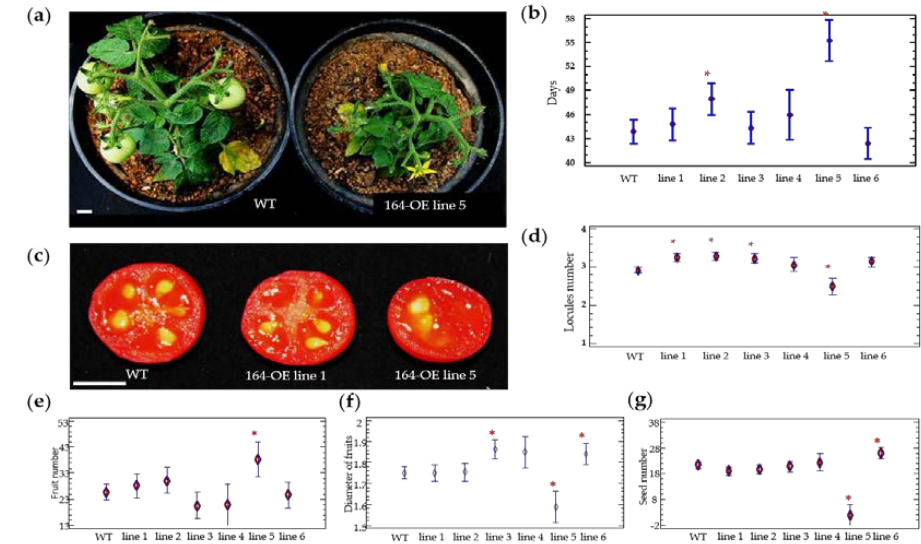
Figure 5. Effect of miR164 overexpression on fruits of tomato. ( a ) Comparison of wild type (WT) and 164-OE line 5 plants of 50 days of age; ( b ) Days that the different lines required to develop the first fruit, WT n = 10, line 1 n = 5, line 2 n = 5, line 3 n = 5, line 4 n = 3, line 5 n = 3, line 6 n = 6; ( c ) Effect in the locule number; ( d ) Number of locules per fruit plotted for each line, (WT n = 215, line 1 n = 128, line 2 n = 108, line 3 n = 94, line 4 n = 33, line 5 n = 26, line 6 n = 73); ( e ) Fruit number; ( f ) Diameter of fruits; and ( g ) Seed number in fruits of the different 164-OE lines. n indicates the number of plants or fruits analyzed. For all cases, the means and LSD intervals at a confidence level of 95% were plotted. * indicates that there is a statistically significant difference. Scale bars = 1 cm.